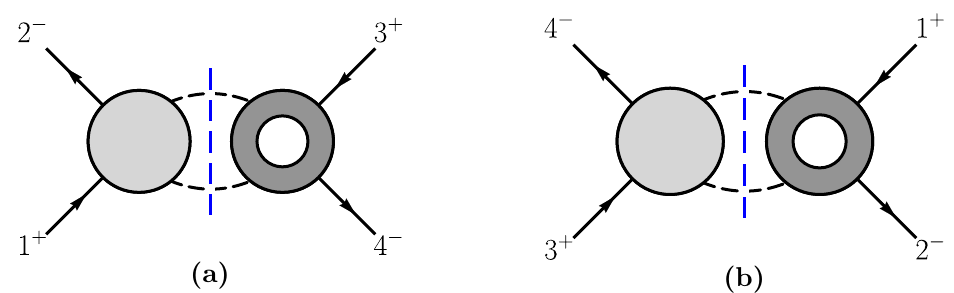
Figure 5 . The (12)-channel (a) and (34)-channel (b) unitary cuts which determine the renor- malization of O by O or O . The (23)- and (14)-channel cuts are given by the ( 4 ) 1 ( D 2 ’ 4 ) 1 ( D 2 ’ 4 ) 2 exchange of legs 2 and 4. In each, the darker blobs indicate a higher-dimension operator insertion, and the vertical (blue) dashed line indicates the integral over phase space of the particles crossing the